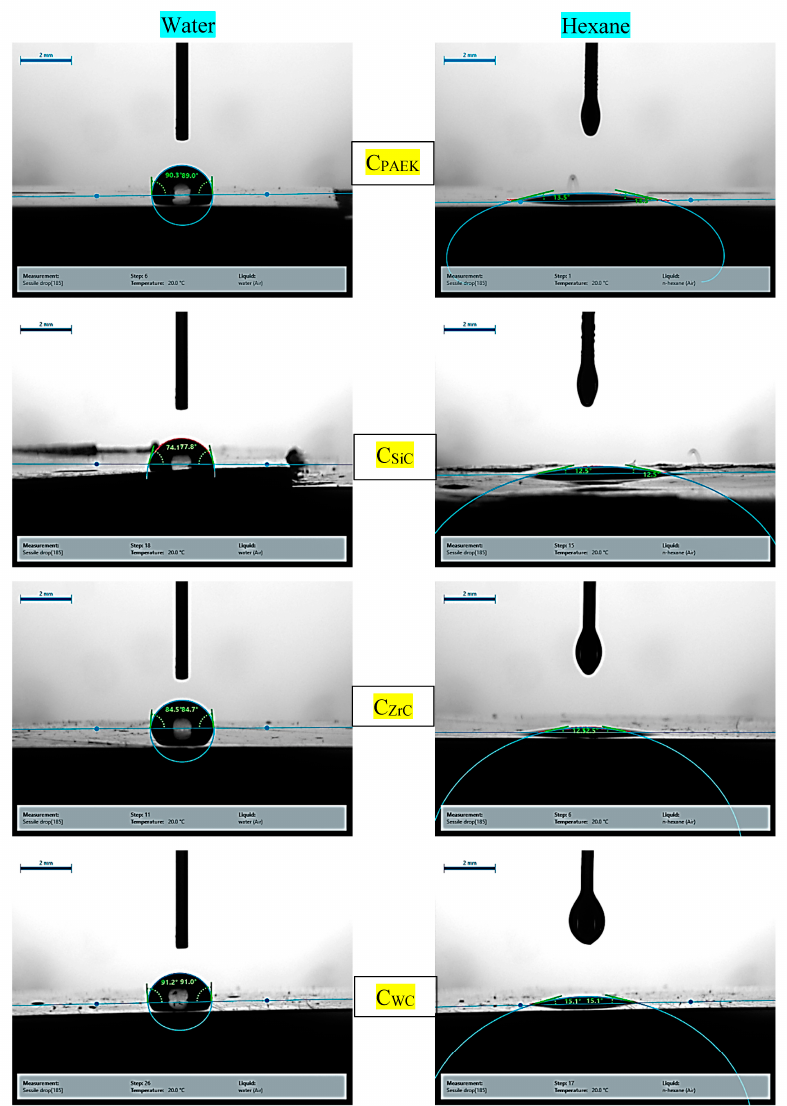
Figure 3. Contact angle images for developed NCs.